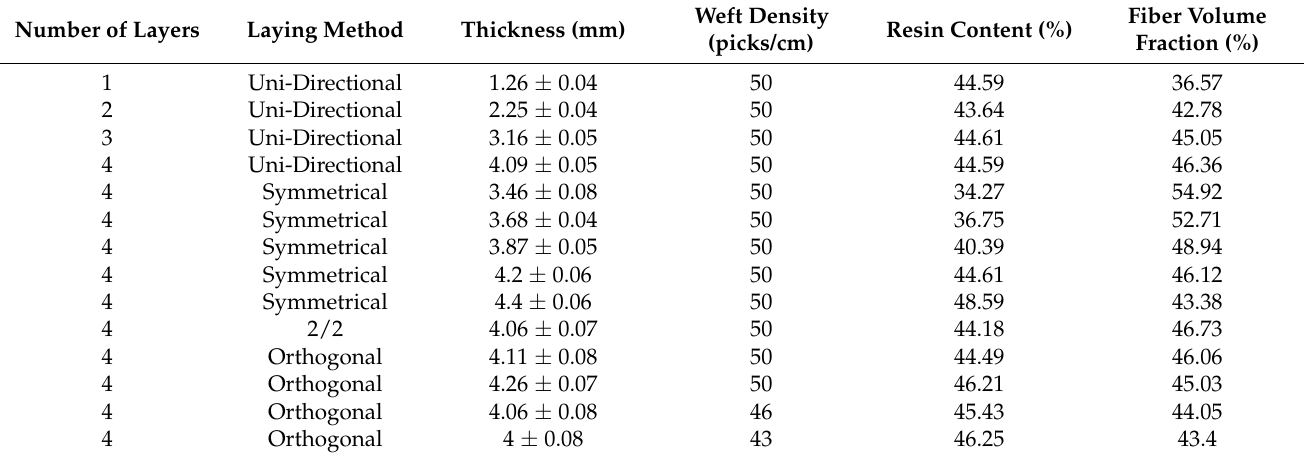
Table 2. The detailed parameters of the 3DDAI Kevlar/EP armor